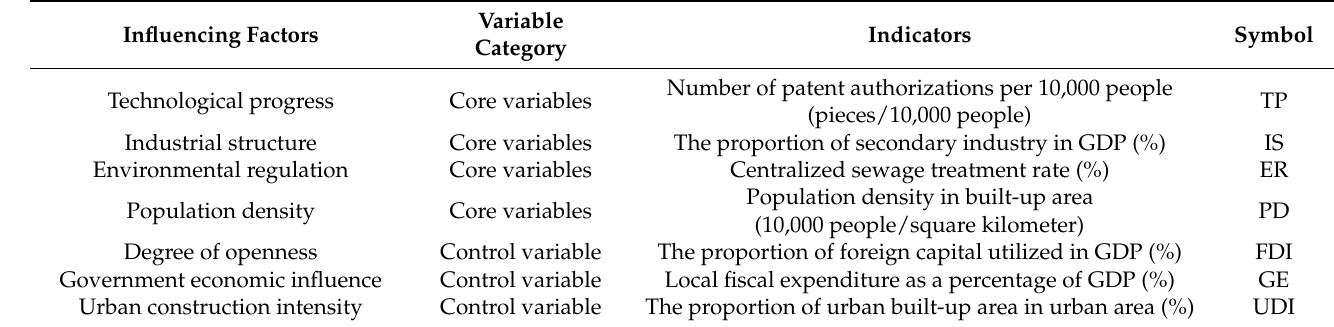
Table 4. Influencing factors of EWP in MRYRUA.